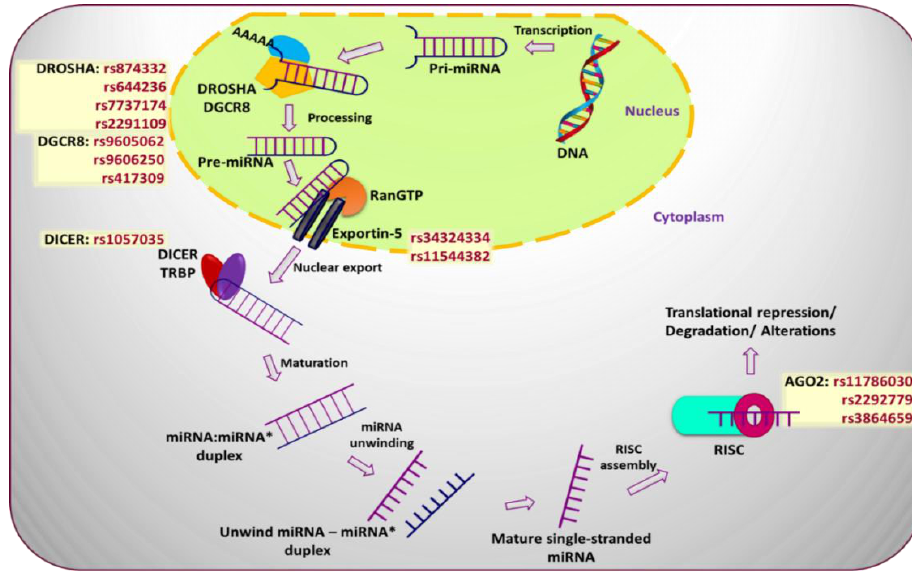
Figure 2. miRNA biogenesis pathway and various single nucleotide polymorphisms (SNPs) occurring at different steps of the pathway that play a pivotal role in prediction of breast cancer risk